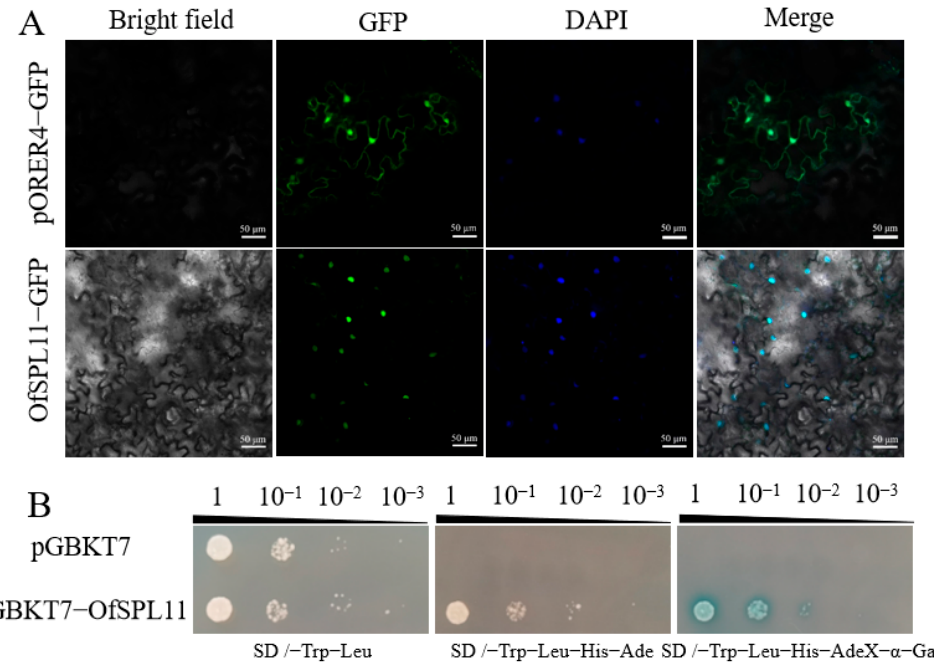
Figure 3. Subcellular localization and transcriptional autoactivation analysis of OfSPL11. ( A ) Subcellular localization of OfSPL11. Green indicates green fluorescent protein, and blue indicates DAPI nuclear localization signal. Scale bars = 50 μ m; ( B ) transcriptional autoactivation analysis of OfSPL11.